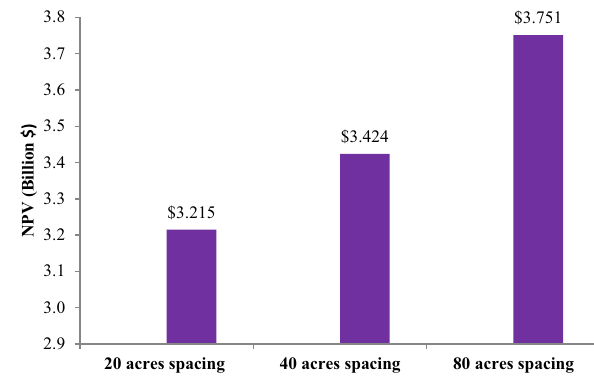
Fig. 11 Cumulative oil production versus time for 3 vertical infill wells at different well spacings